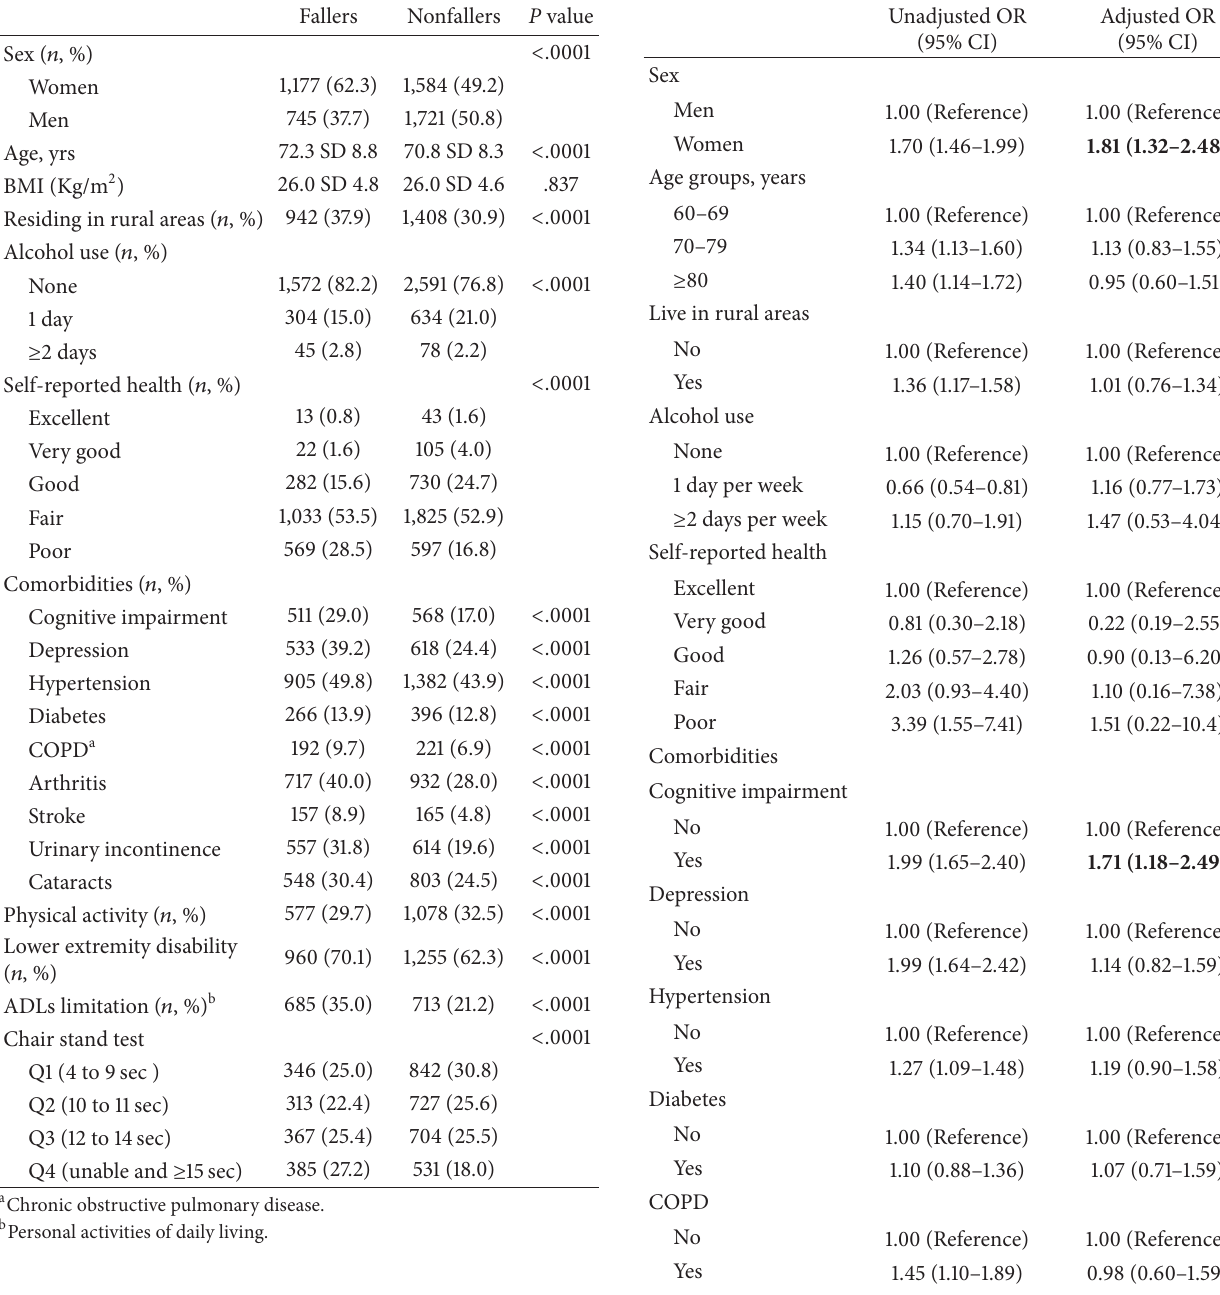
Table 1: Demographic and clinical characteristics of survey partic- ipants, SABE I.